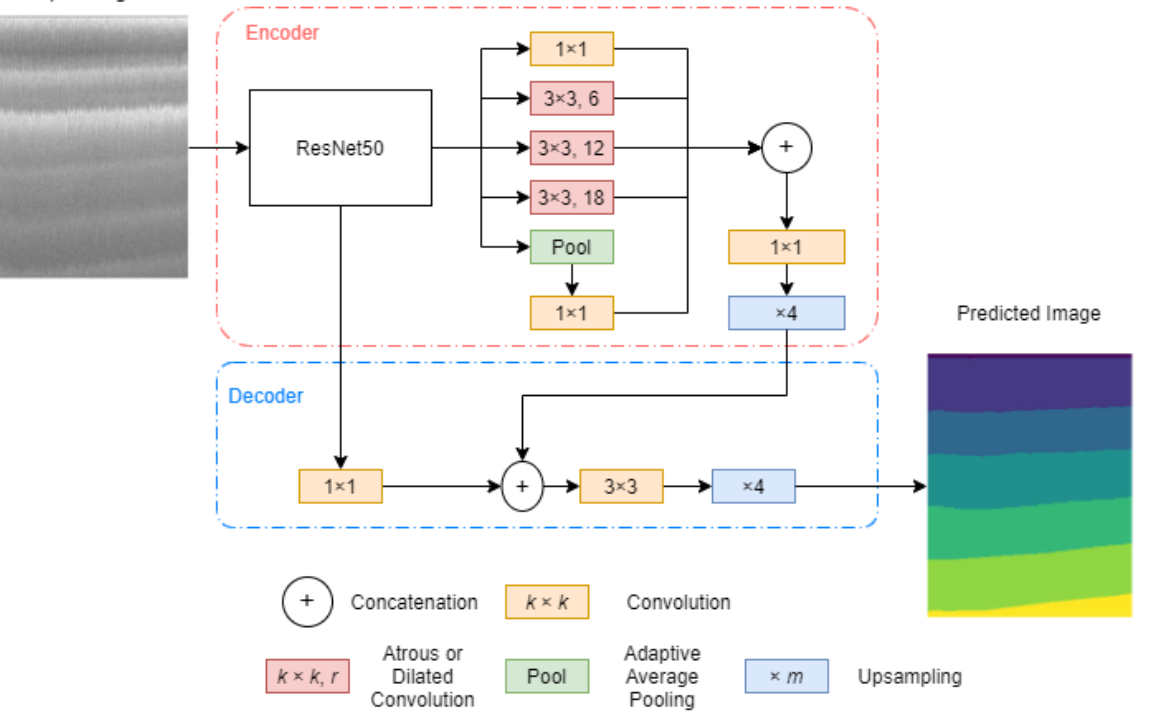
Figure 8. DeepLabv3+ [25] architecture with ResNet50 [31]